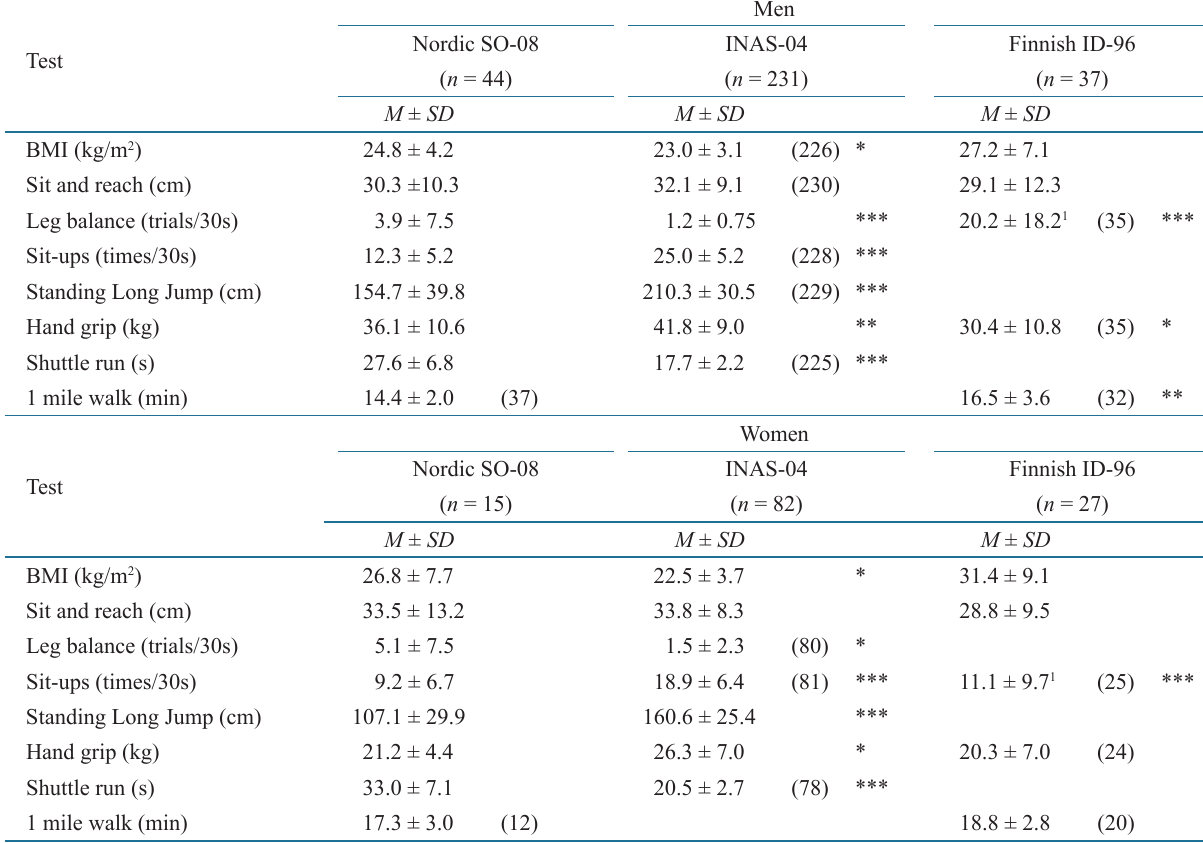
Nordic athletes’ test performances compared with reference populations